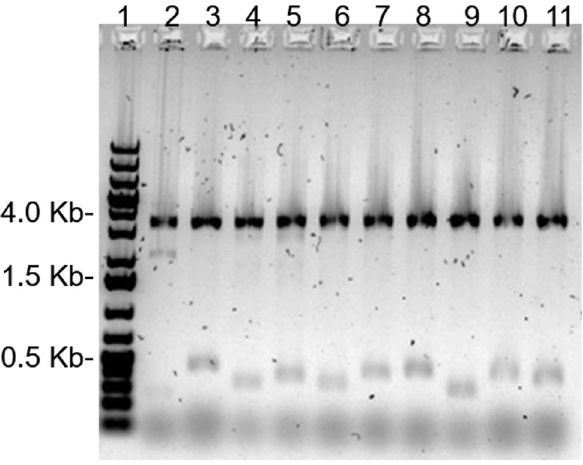
Figure 2 - Restriction analysis of plasmids extracted from potential posi- tive clones digested with Hind III and Nde I in agarose gel 0.8% (w/v). Line 1: molecular marker GeneRuler 1kb Plus DNA (Thermo Fisher – Waltham, EUA), line 2: empty pSEVA232; lines 3-11: plasmids extracted from clones NS1 to NS9.